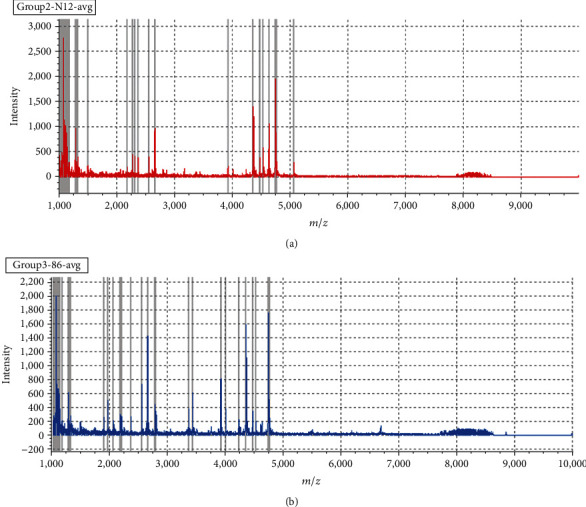
Typical urinary sample mass spectra from MALDI-TOF-MS after being purified by MB-WCX: (a) one sample of a normal pregnant woman; (b) one sample of a GDM patient.